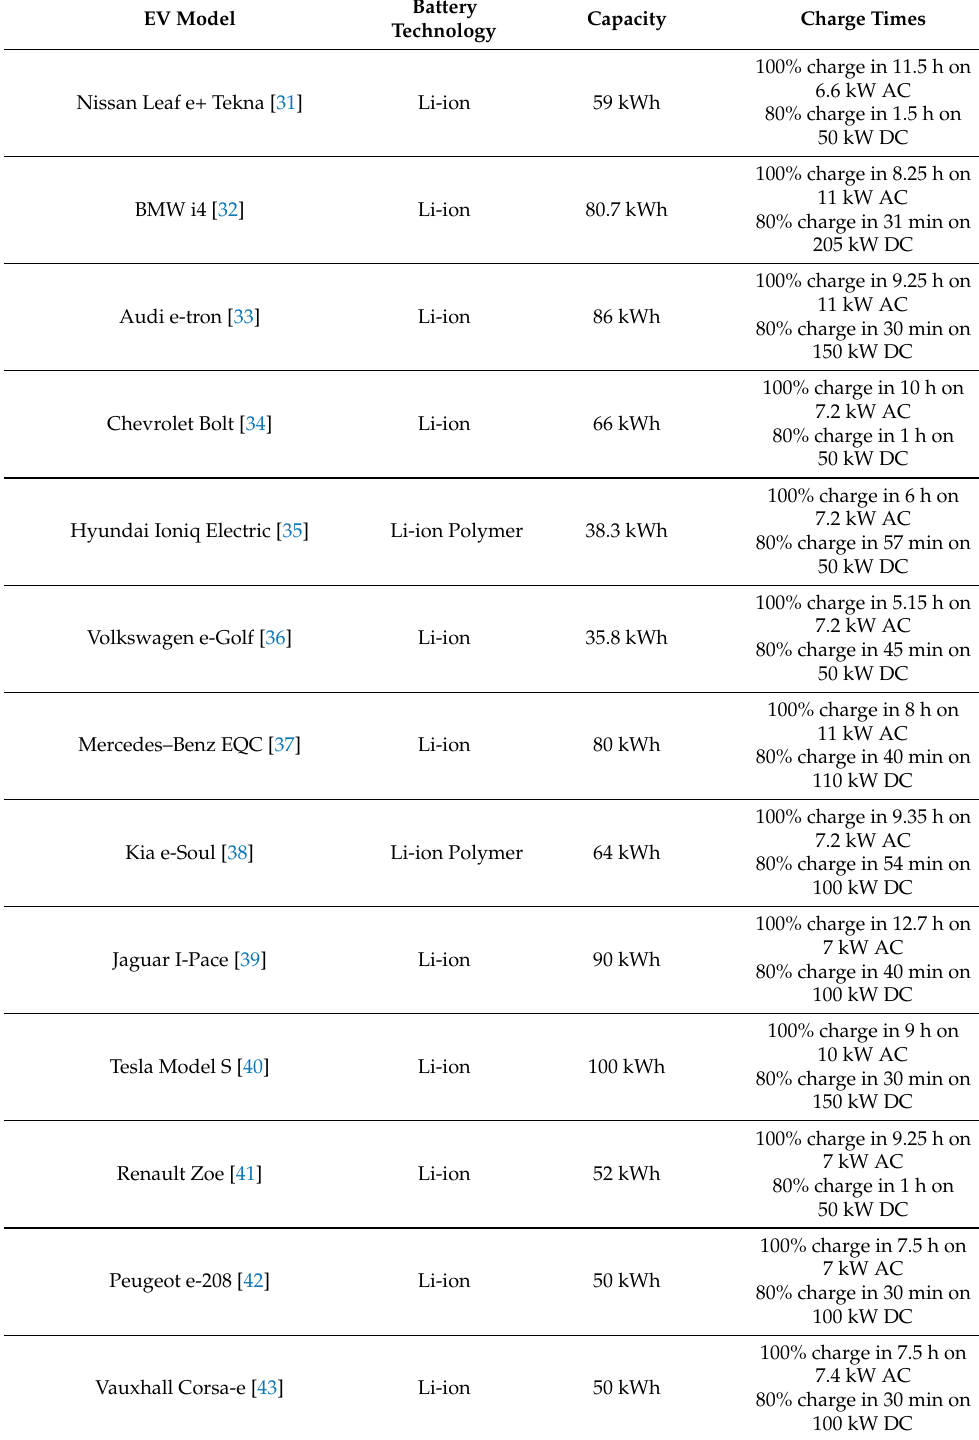
Table 1. Overview of different EV passenger models considering battery technology, capacity and charge